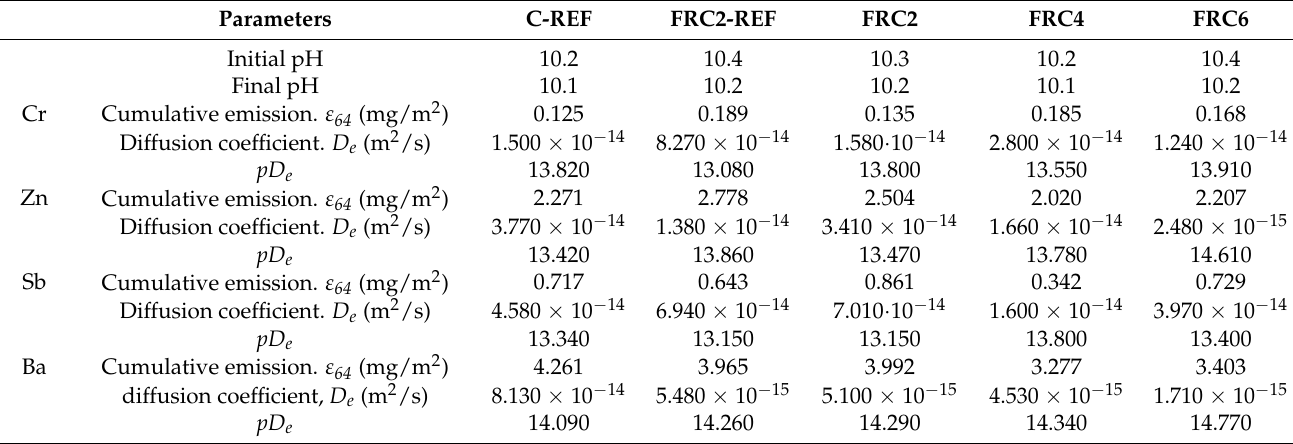
Table 4. Cumulative emission ( ε 64 ), diffusion coefficient ( D e ) and pD e